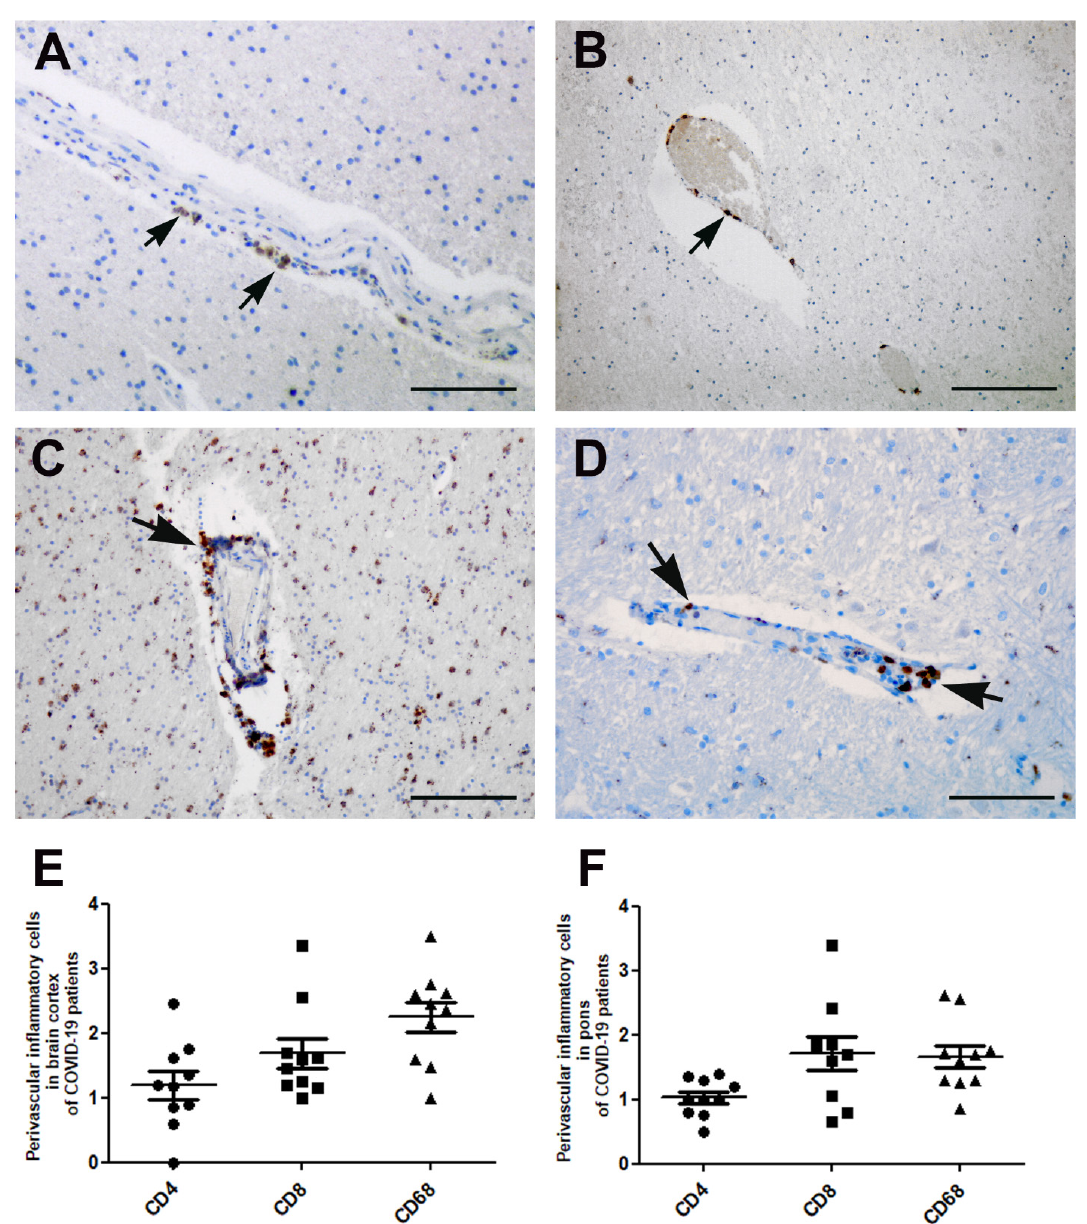
Figure 7. Inflammatory cells immune-characterization in the cerebral cortex and pons areas. ( A ) Lymphocytic inflam- mation in the cerebral cortex targeting the vessel wall showed the presence of CD4-positive lymphocytes (arrows) and ( B ) CD8-positive cells (arrow). ( C ) Numerous inflammatory cells are macrophages, as demonstrated with anti-CD68 immunohistochemistry in the cerebral cortex (arrow) and ( D ) pons area (arrows). ( E ) Mean number of perivascular inflammatory cells in the cerebral cortex and ( F ) pons area. Images from patients who did not have previous neurological deficits. Scale bars: ( A , D ) = 50 μ m; ( B ) = 200; ( C ) = 100 μ m.